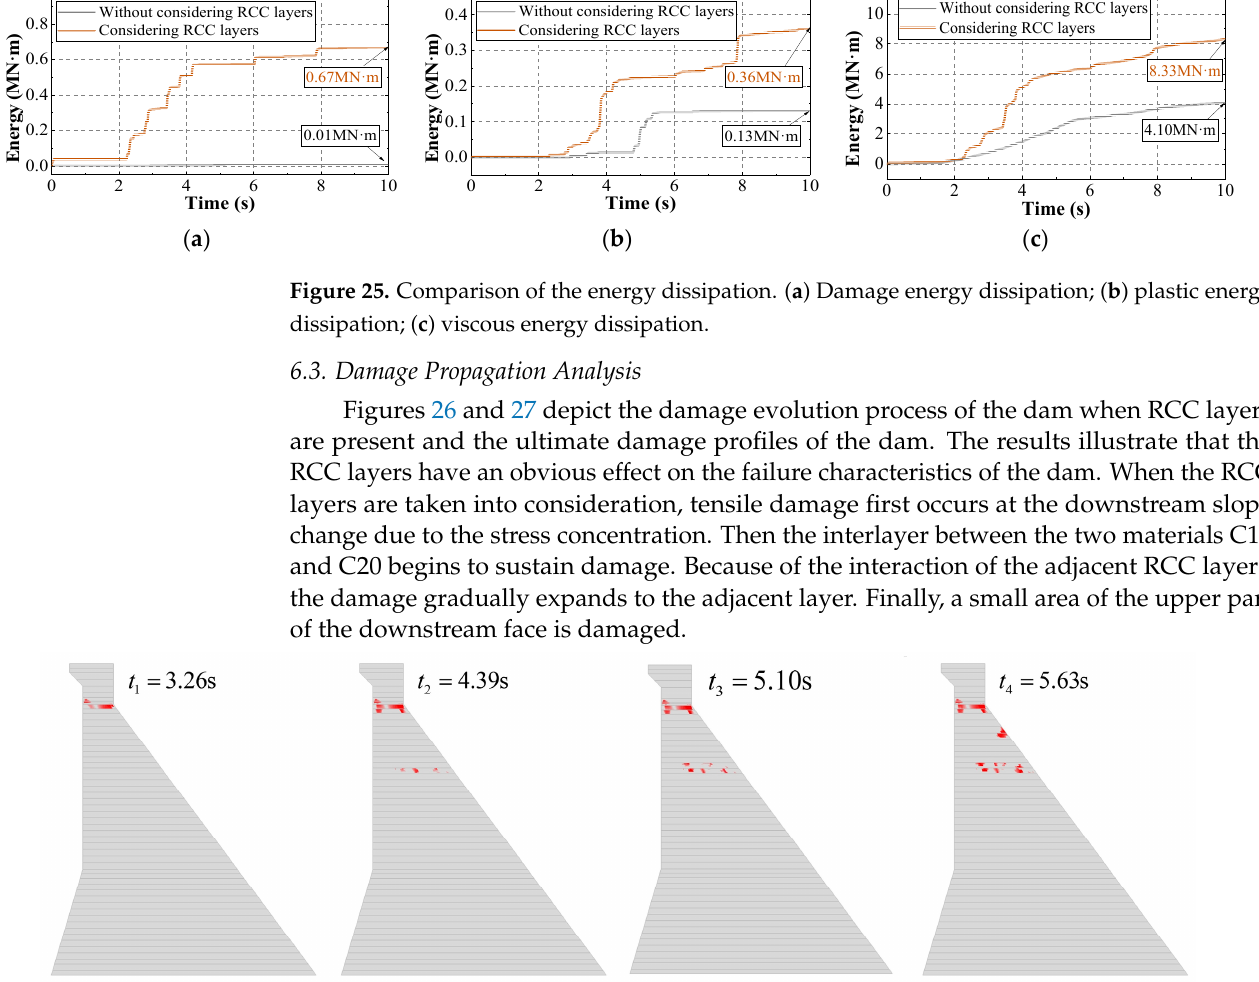
Figure 26. Damage evolution process of the dam with RCC layers.